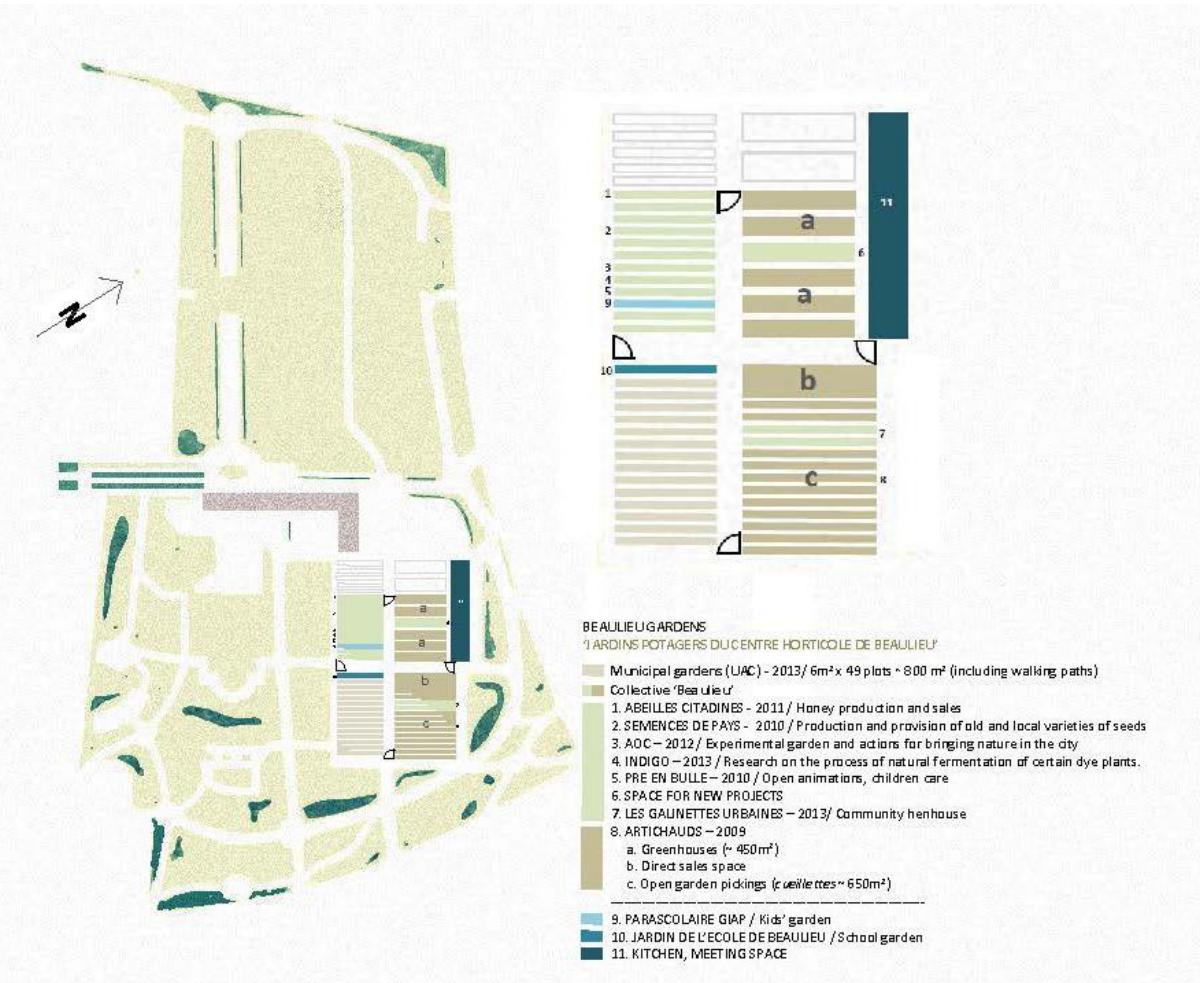
Figure 3. The Beaulieu Gardens: Multiple actors and functions. Source: Nikolaidou, 2014 (based on a map image layer of the park, Ville de Genève, 1993, p.